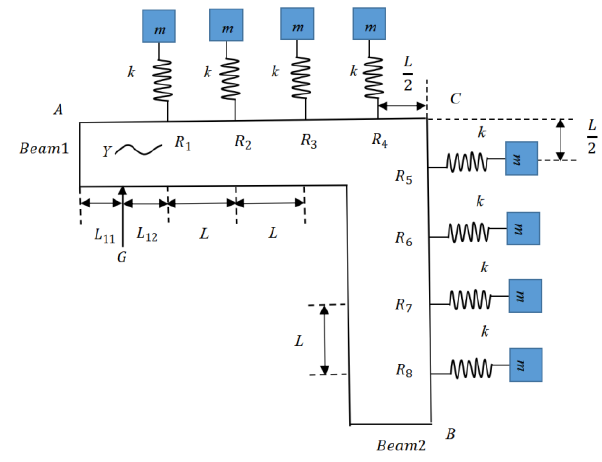
Figure 9. Equivalent model of the proposed LR beam for the wave-based approach.